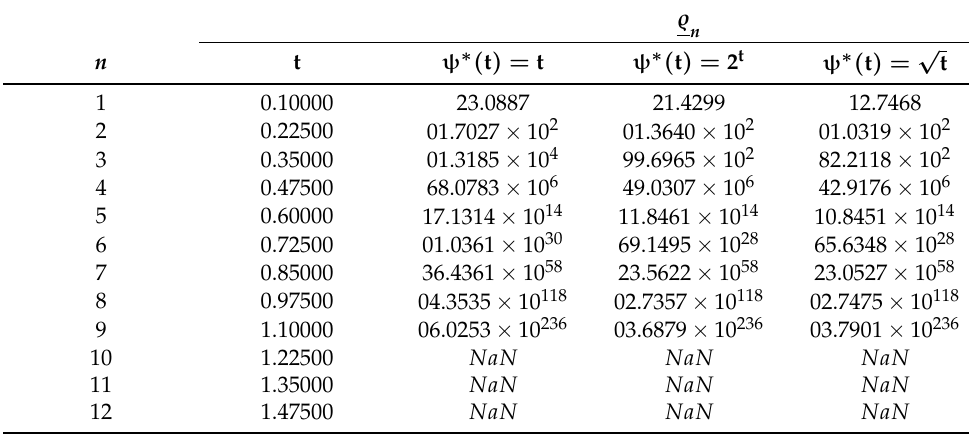
for ψ ∗ ( t ) = t,2 t , n